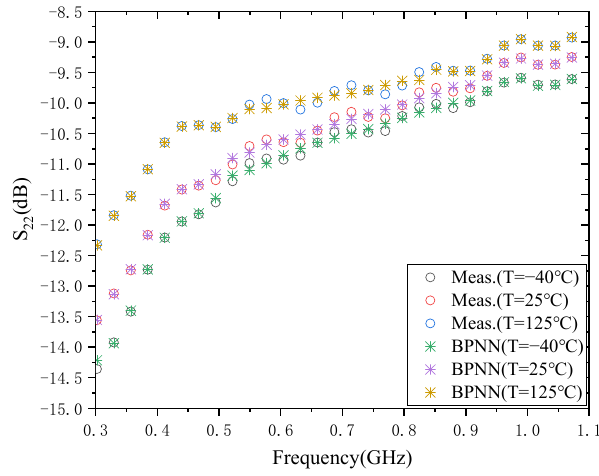
Figure 6. Modeling results of S 22 .